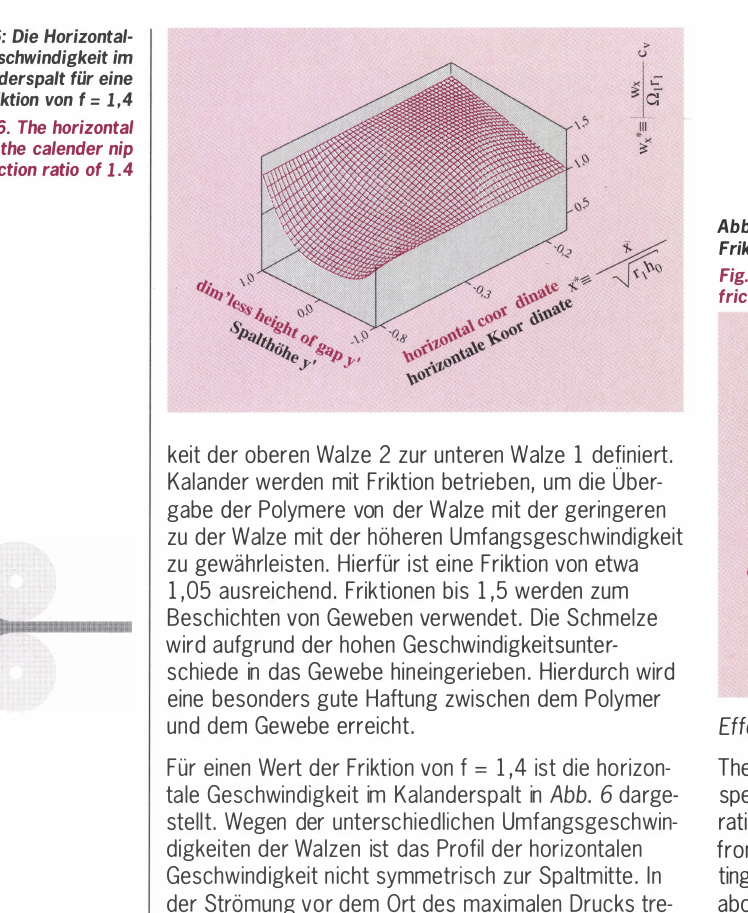
Fig. 7. The temperature in the calender nip for a friction ratio of 1.4